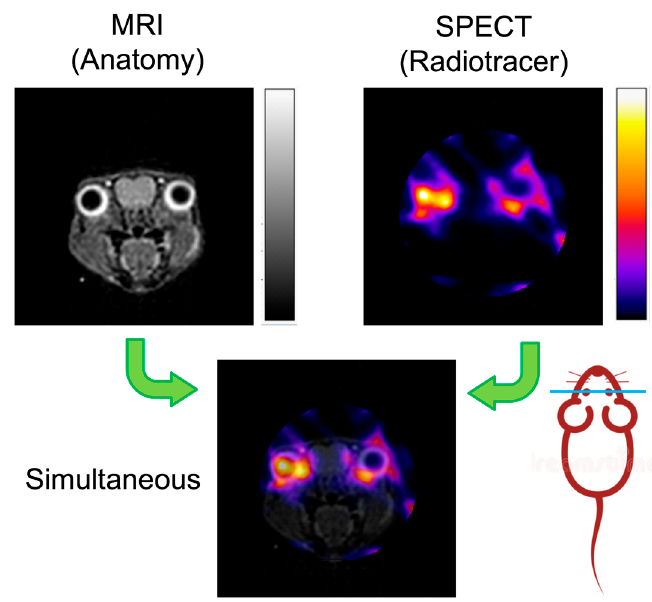
Figure 6. An example (15 mm-diameter axial slice of a mouse head) of multimodal imaging combining simultaneous magnetic resonance imaging (MRI (anatomical details)) with SPECT.